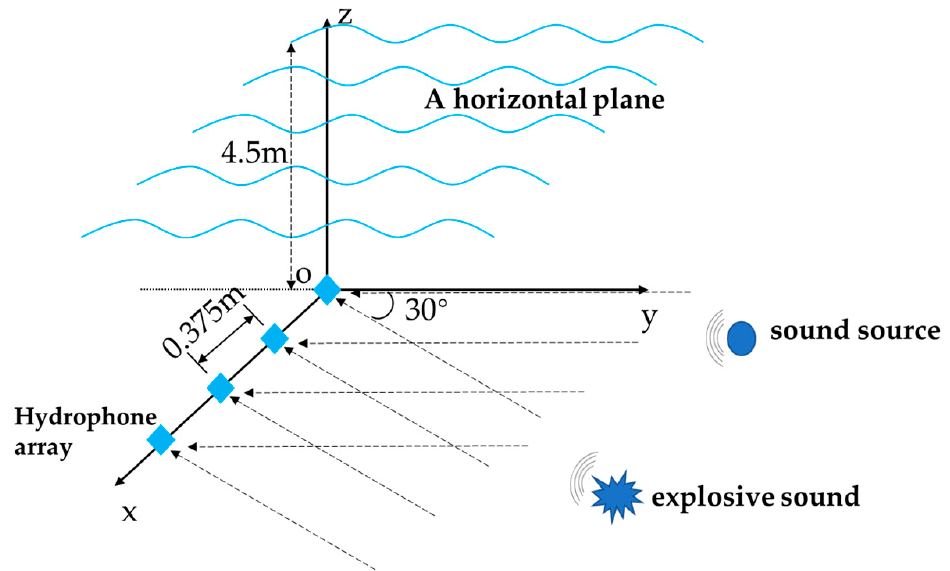
Figure 20. Schematic diagram of the mixing experiment of single sound source and explosion sound.